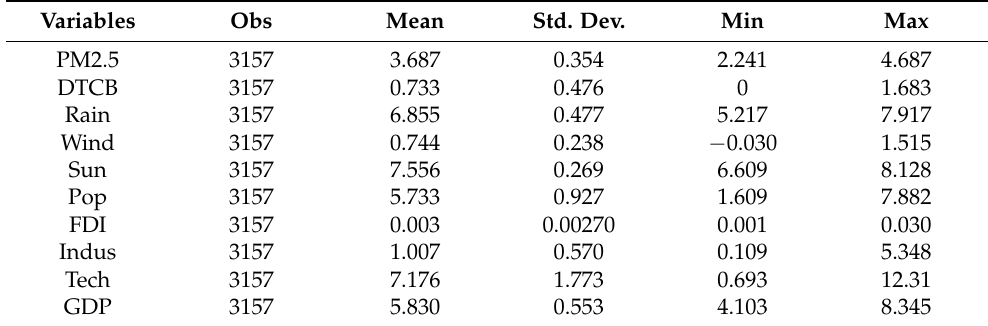
Table 1. Descriptive statistics.